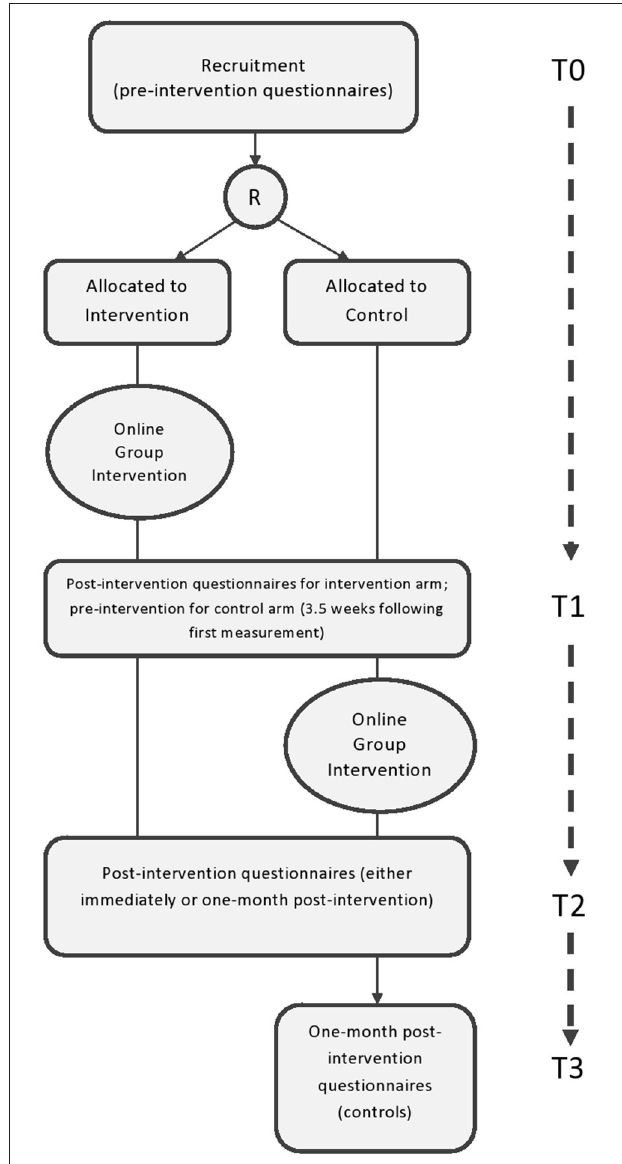
FIGURE 2 | Participant flow chart and